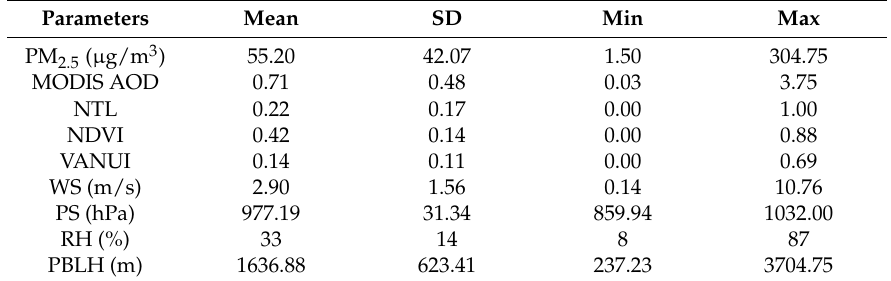
Table 1. Descriptive statistics summarizing observations for PM 2.5 monitoring sites for 2016 ( N = 3674).